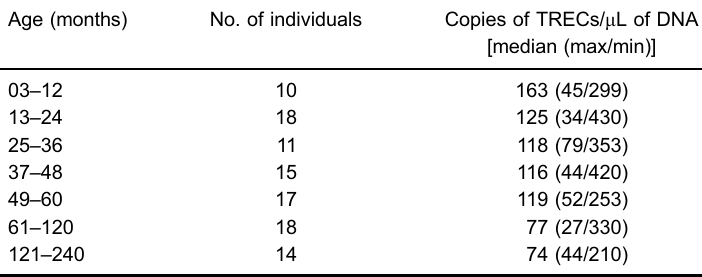
Table 1. Levels of Tcell receptor excision circles (TRECs) according to age